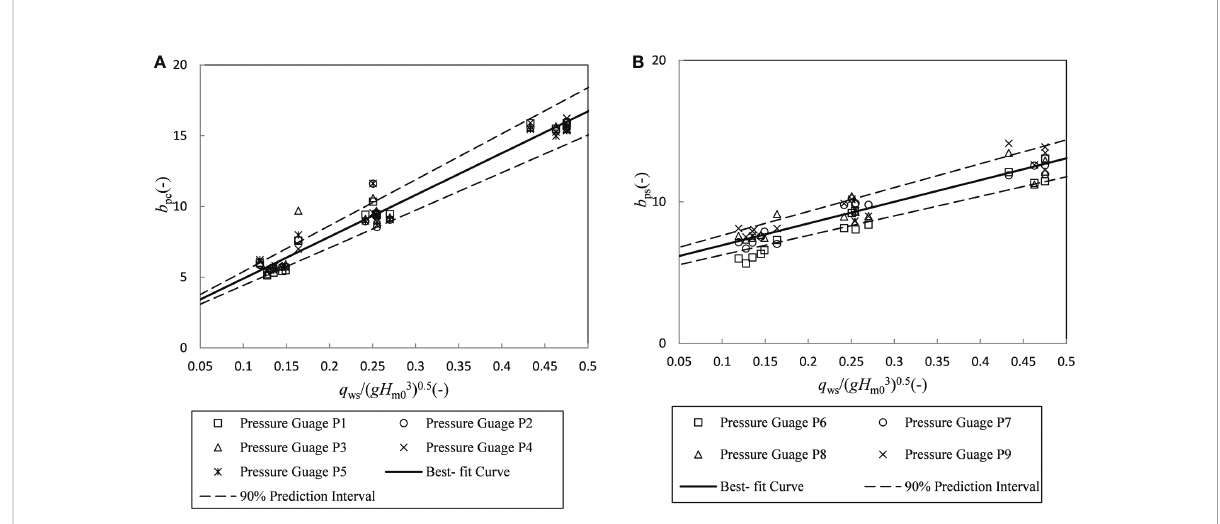
FIGURE 12 Best- fi t equations for Weibull factor b p : (A) on the crest; (B) on the upper part of landward